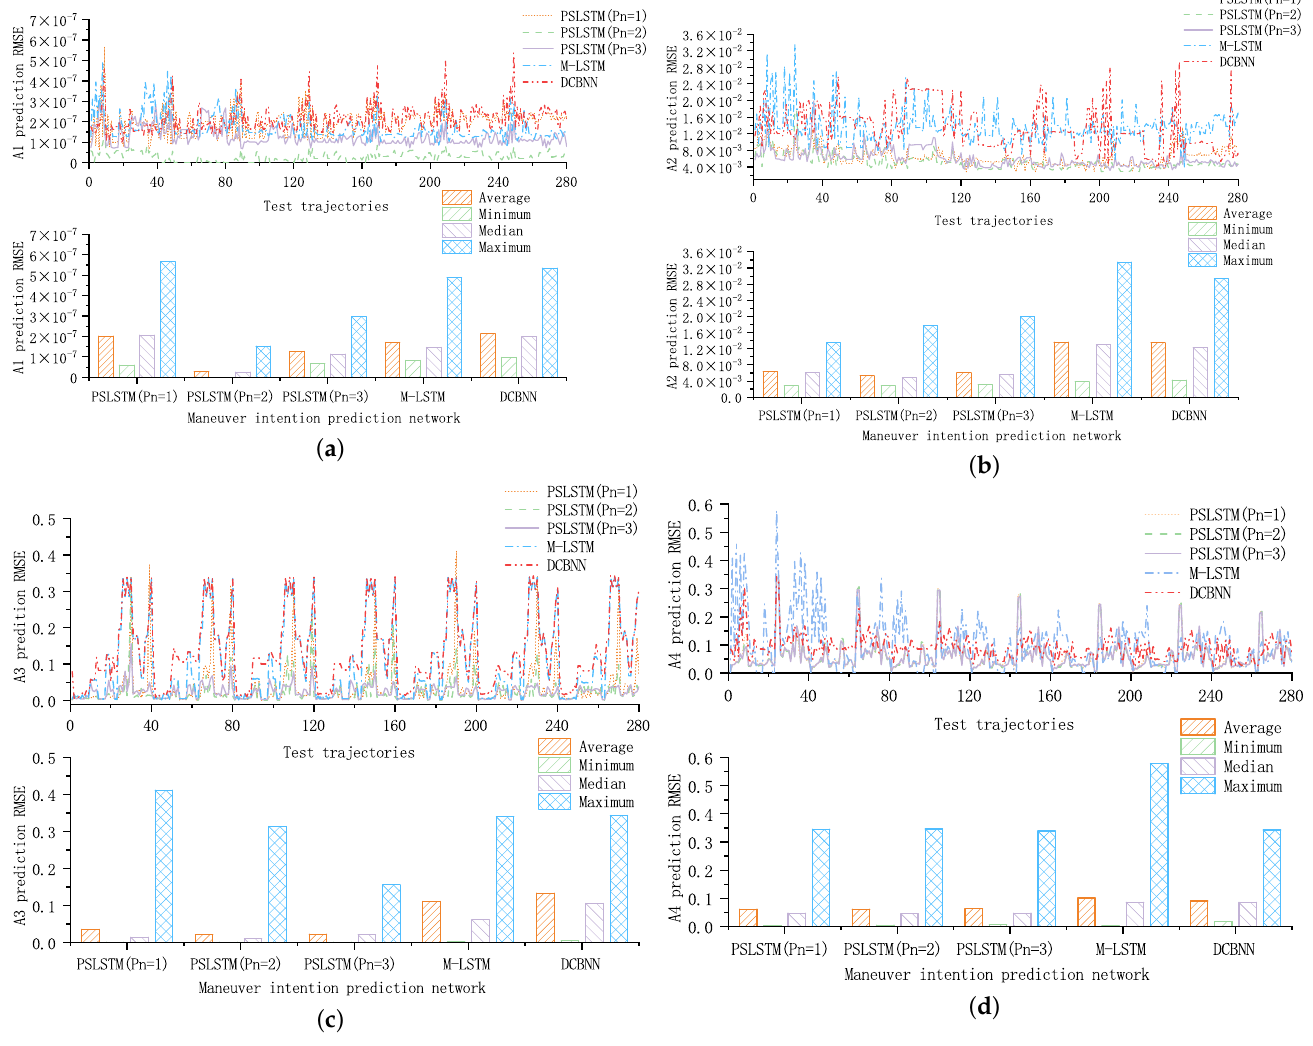
Figure 12. Prediction error of the maneuver intention prediction network ( QEG ): ( a ) is the error of A1 prediction, ( b ) is the error of A2 prediction, ( c ) is the error of A3 prediction, and ( d ) is the error of A4